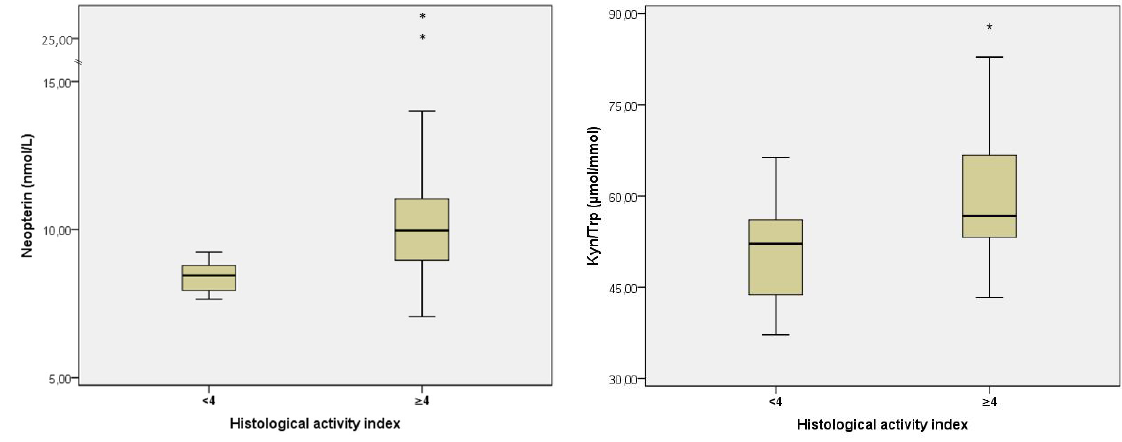
Figure 1: The comparison of serum concentration of neopterin and IDO activity in patients with HAI <4 and HAI ≥4. HAI: histological activity index. The upper and lower portions of the boxes indicate 25 th and 75 th percentiles, respectively. Horizontal lines within the boxes indicate the 50 th percentile (median).